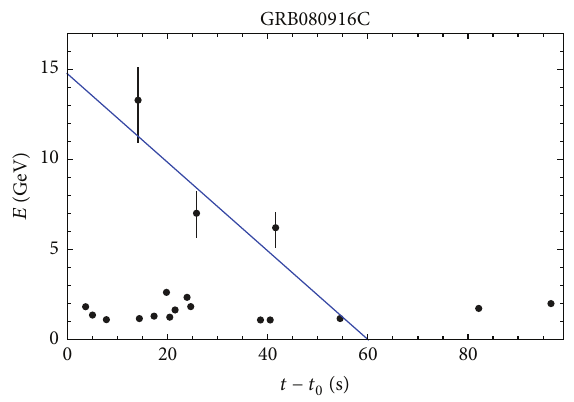
Figure 10: Here shown is the Fermi-LAT sequence of photons with energy greater than 1GeV for GRB080916C. We visualize error bars at the 15 % level for the energies of the most energetic events, which play a special role from our perspective. The slope of the straight line here shown is not fit on this data but rather is obtained from the slope fit in Figure 4 (for GRB130427A) by rigidly rescaling it by the factor of 𝐷(0.34)/𝐷(4.35) dictated by